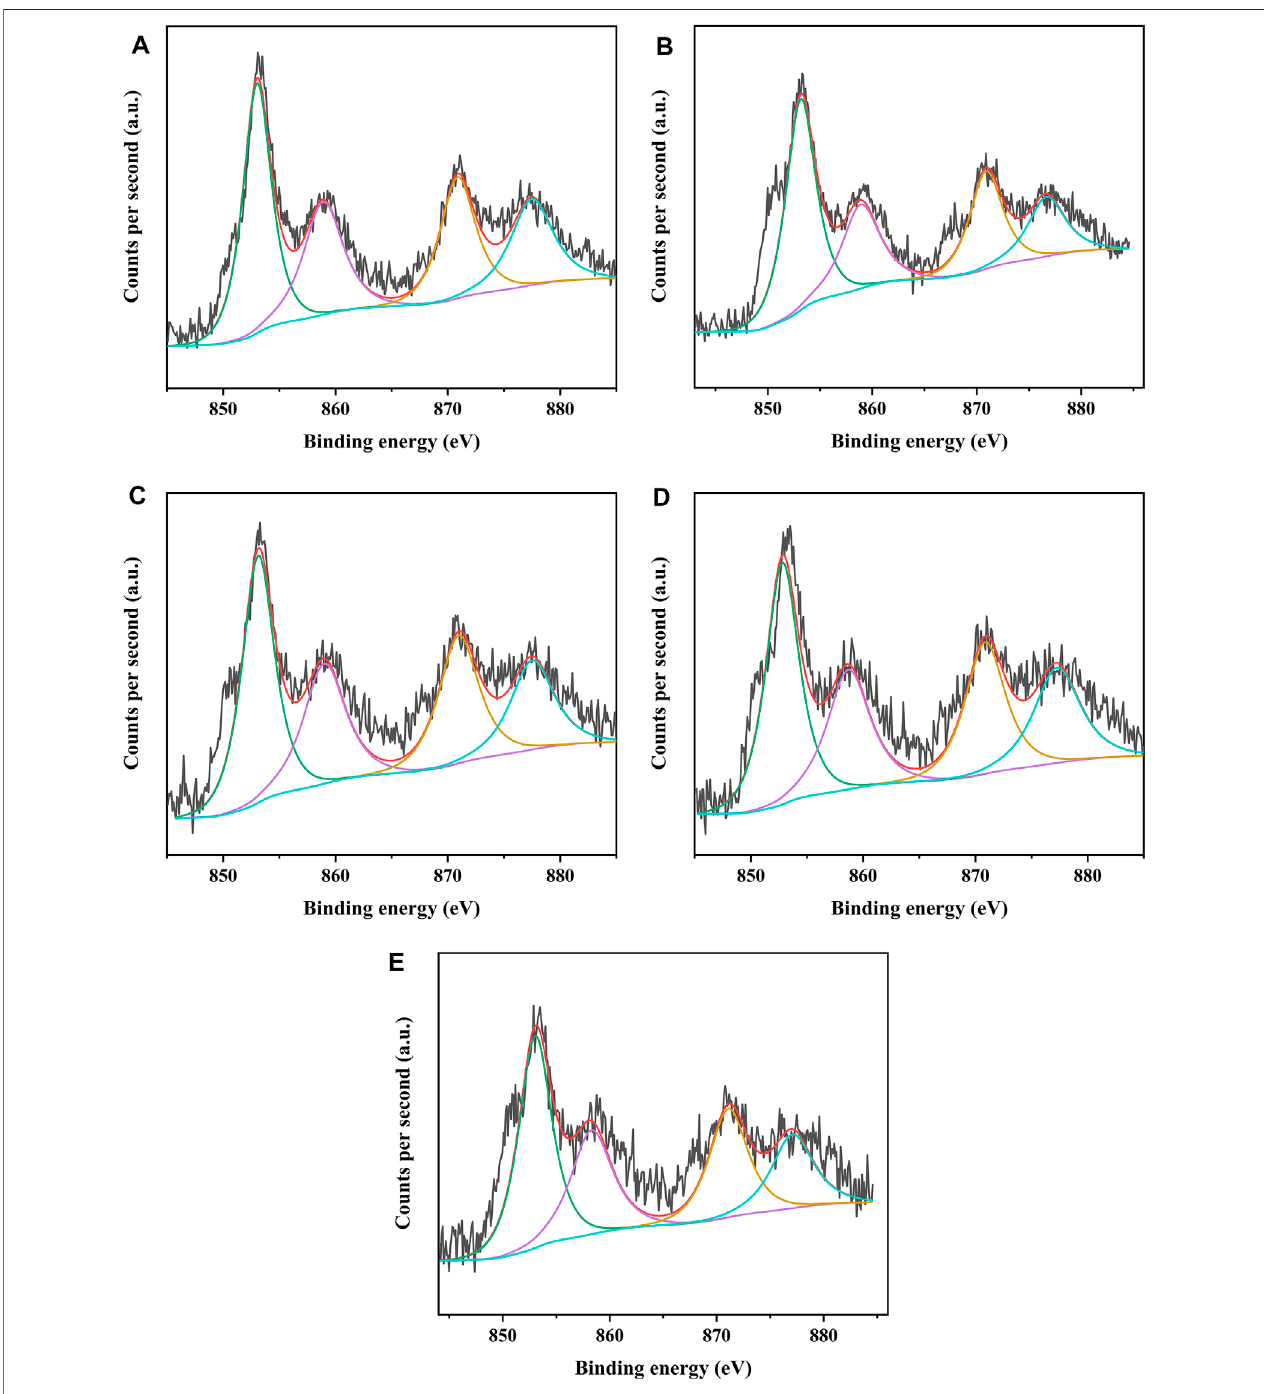
FIGURE 9 | XPS Ni 2p spectra of sul fi ded catalysts: (A) NiW/4Ni-SAPO-11, (B) NiW/3Ni-SAPO-11, (C) NiW/2Ni-SAPO-11, (D) NiW/1Ni-SAPO-11, and (E) NiW/ SAPO-11.